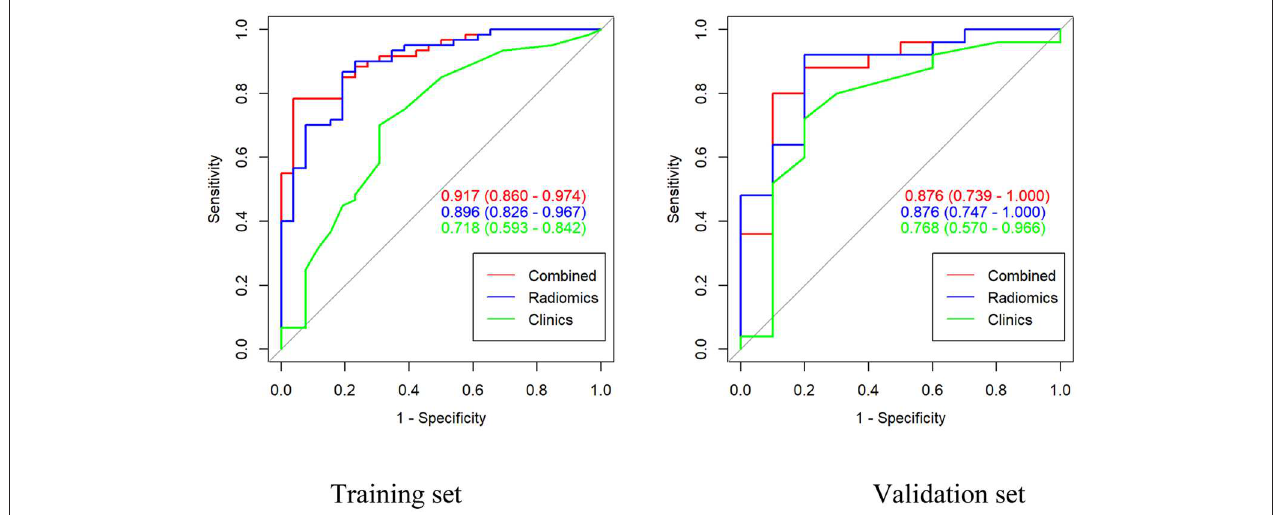
FIGURE 6 | Area under the curve (AUC) of the gross signatures, clinical model, and the combined model in the training cohort and the validation cohort.